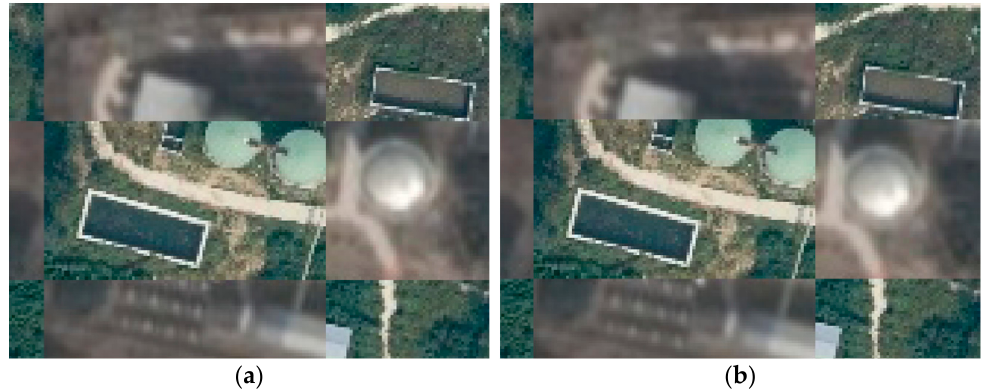
Figure 7. Comparing sample images before and after correction: ( a ) Overlay window of the original satellite orthophoto and UAV orthophoto; ( b ) Windowed overlay of the corrected satellite orthophoto and UAV orthophoto.